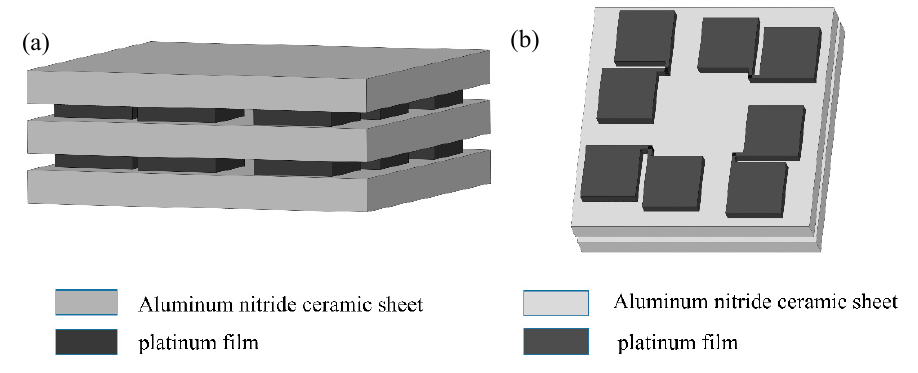
Figure 12. Schematic diagram of the sensor for measuring out-of-plane heat flux. ( a ) 3D schematic of the sensor; ( b ) 3D schematic of platinum deposition.